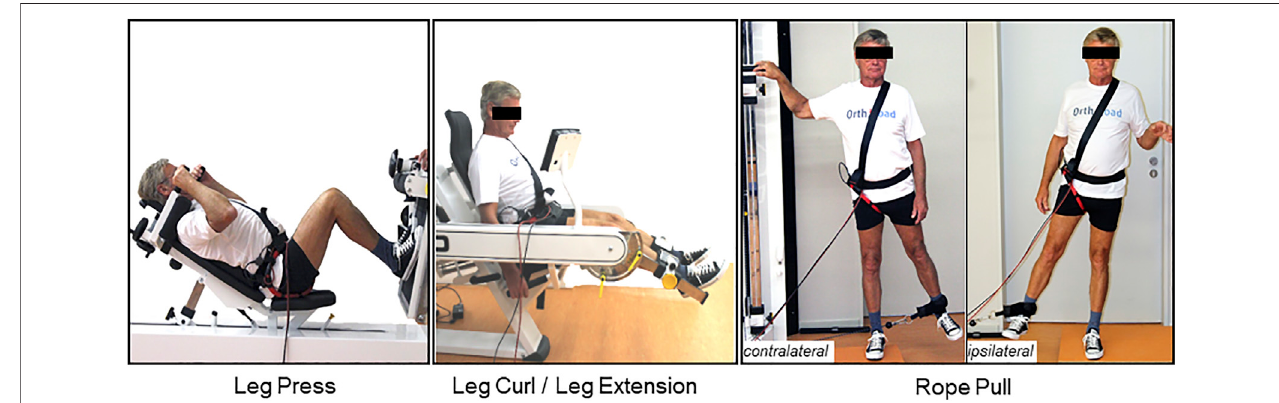
FIGURE1| Depictingtheselectedgymmachines:legpressmachine,legcurlandlegextensionmachine,andipsilateralandcontralateralexercisesontheropepull machine (from left to right) . Ipsilateral and contralateral regarding the implanted instrumented hip prothesis, respectively. Rope pull exercises performed with ipsilateral side, standing on the contralateral leg referred to as ipsilateral. Rope pull exercises performed with contralateral side, standing on the ipsilateral leg referred to as contralateral.